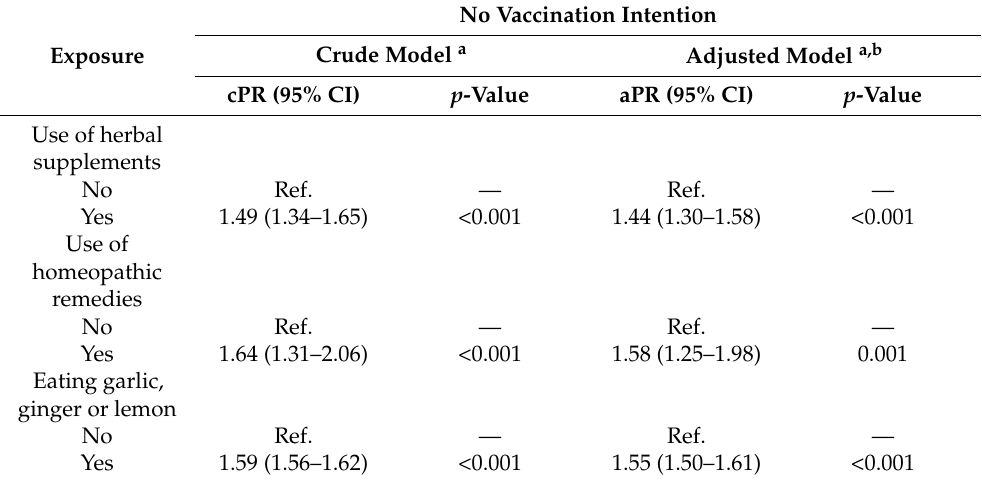
Table 3. Crude and adjusted regression models to evaluate the association between the use of herbal supplements, the use of homeopathic remedies, the consumption of garlic, ginger, or lemon, and non-intention to